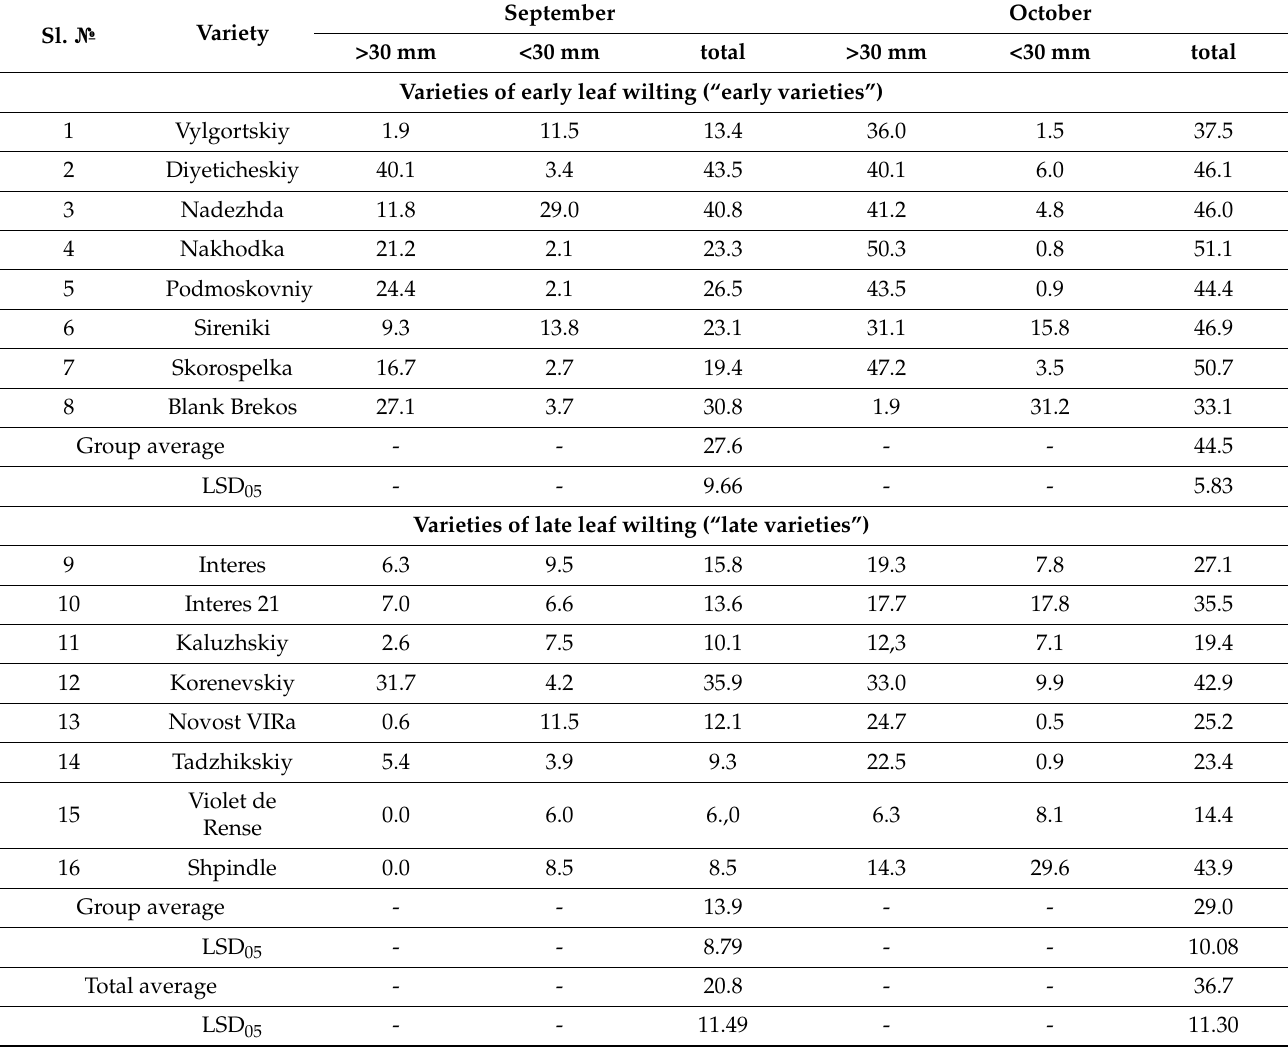
Table 2. Productivity of Jerusalem artichoke tubers (2014–2016),